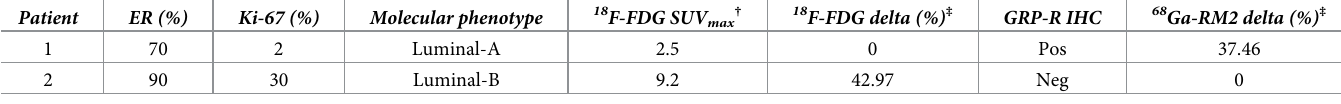
Table 4. 18 F-FDG SUV max on PET/CT imaging in two breast cancer patients according to estrogen receptor (ER) expression, Ki-67 expression, ex vivo 18 F-FDG and 68 Ga-RM2 bindings and GRP-R